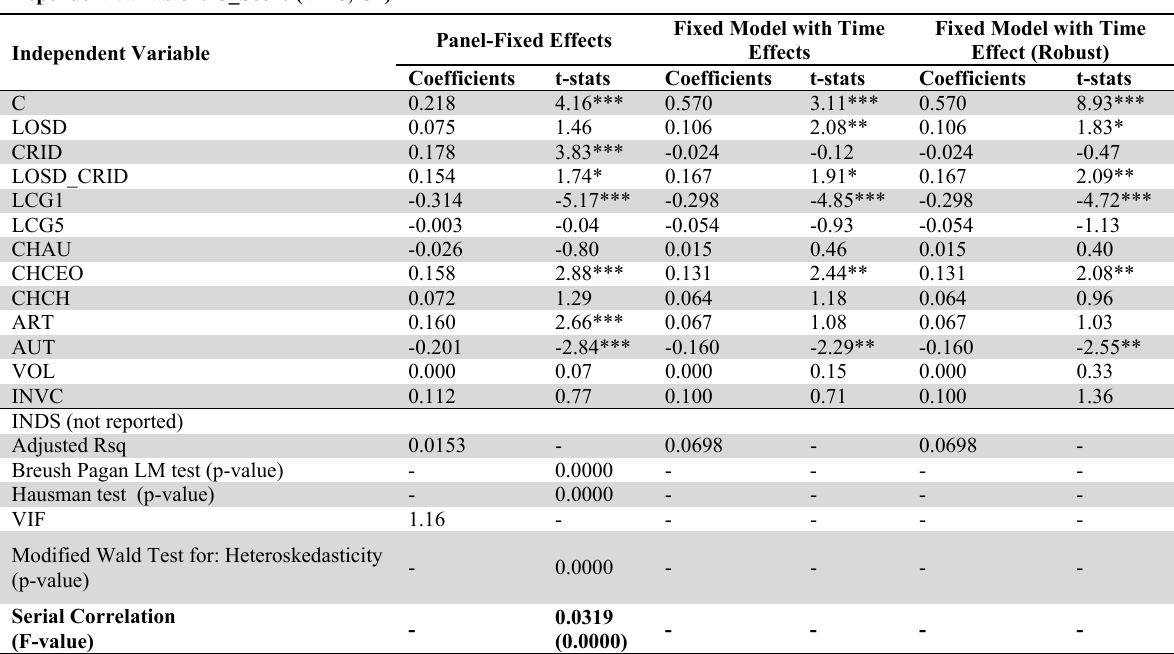
Results of Eq. (4) for regressing C_Score on independent variables on total sample Dependent variable is C_Score ( n = 8,431) Independent Variable